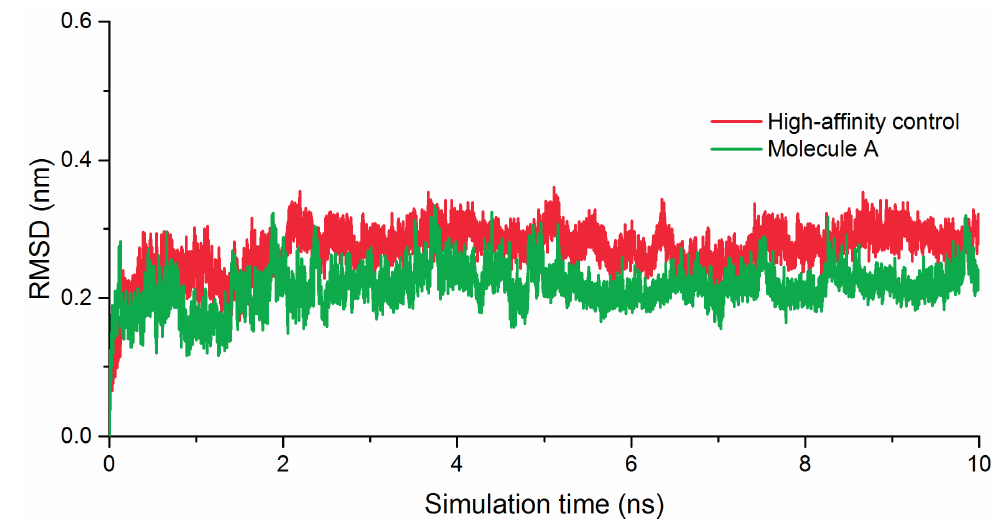
Figure 5. Molecular dynamics simulation data. RMSDs of the high-affinity control (HAC) and molecule A in complex with NP T-loop pocket are shown. The RMSDs were calculated on the molecules after least squared fitting of the